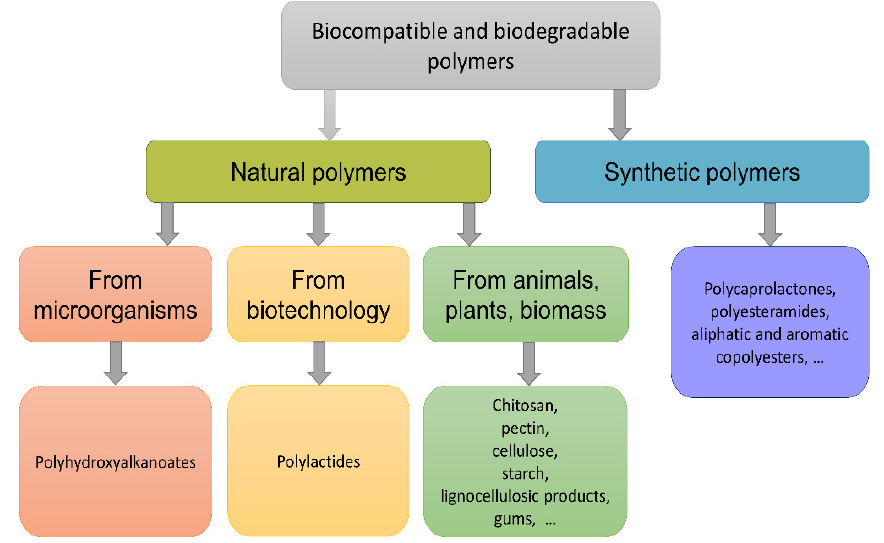
Figure 1. Classification of biodegradable polymers. Adapted from [11].